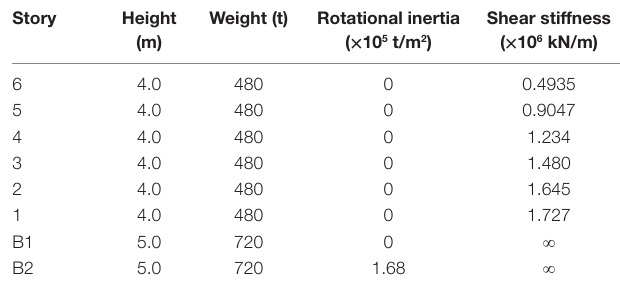
TaBle 3 | Property of